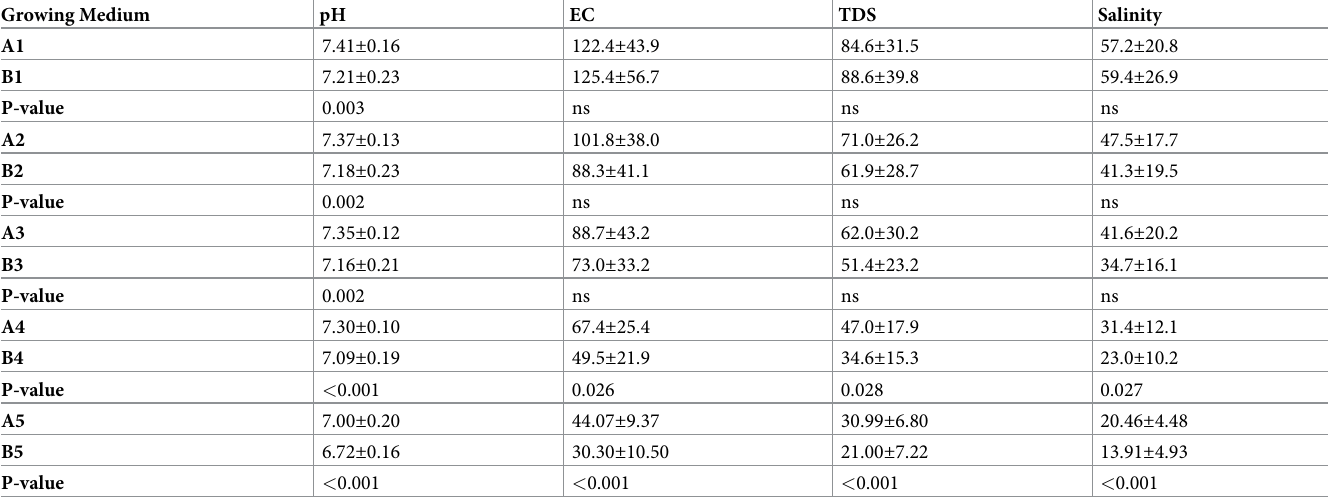
Table 2. Two-sample independent t-test for comparing electrical conductivity (EC), total dissolved solids (TDS), salinity and pH for vermicast-sawdust mixed media without (A) and with (B) Trichoderma viride in the nutrient release experiments. Growing